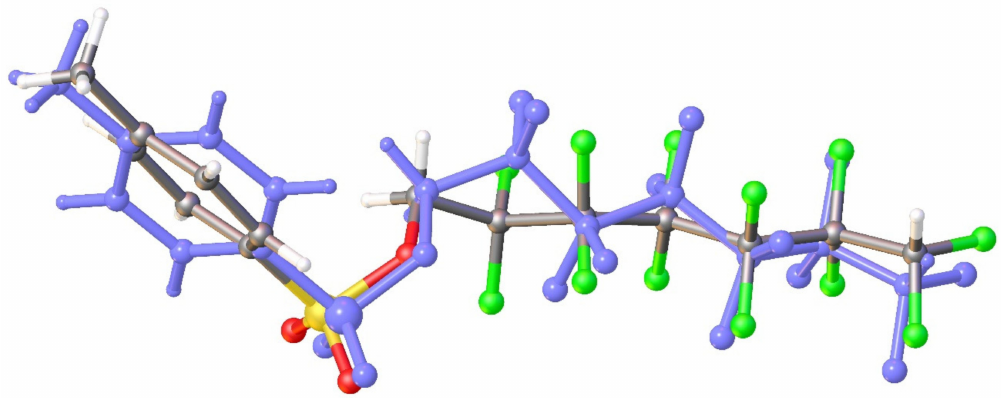
Figure 5. Overlaid molecular structures of polymorphs 3a (colored by element) and 3b